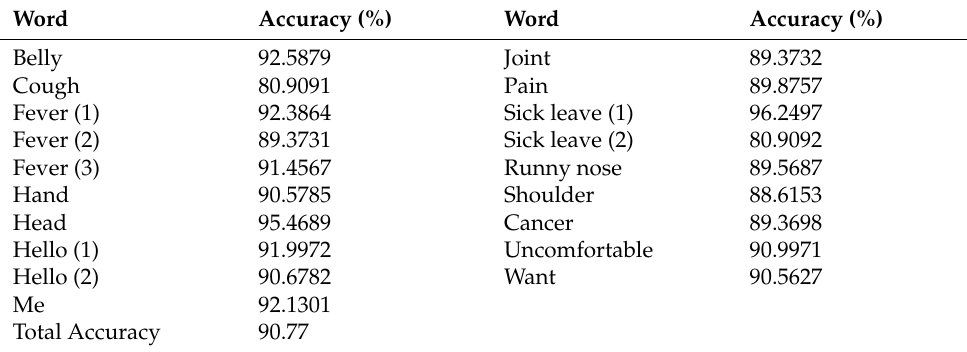
Table 1. The accuracy of sign language word recognition.